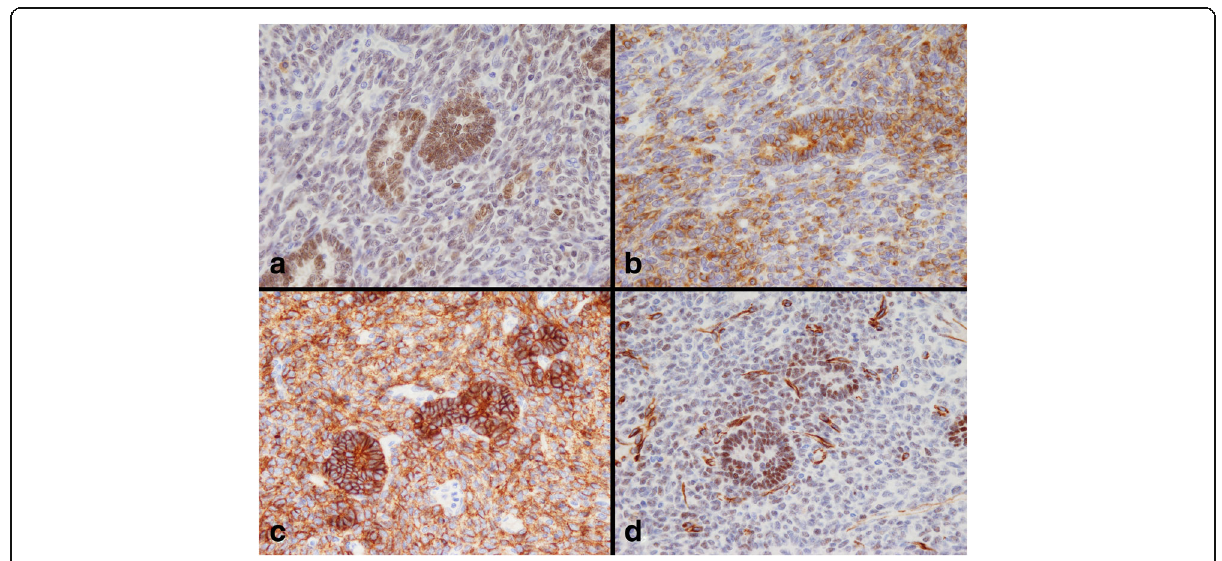
Fig. 4 Immunohistochemical findings of the mesenteric tumor. a SF-1, ( b ) inhibin- α , ( c ) CD56, ( d )